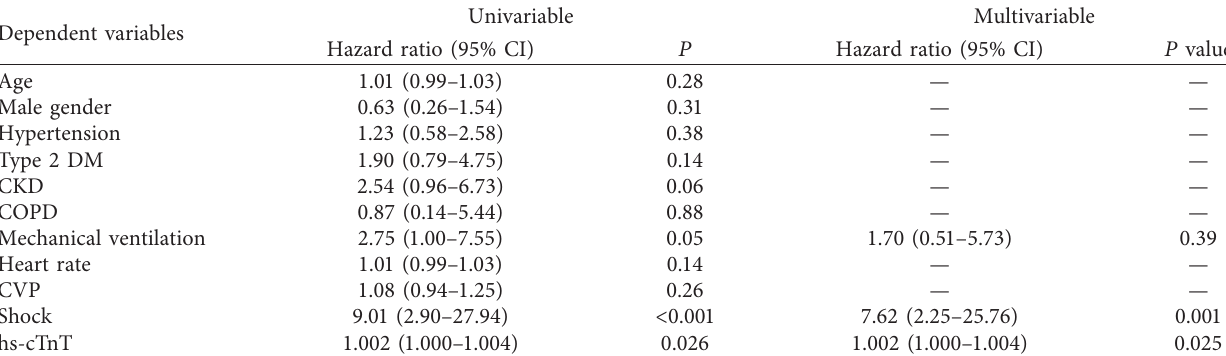
Table 3: Univariate and multivariate logistic regression analysis for the detection of subclinical left ventricular systolic dysfunction. Dependent variables